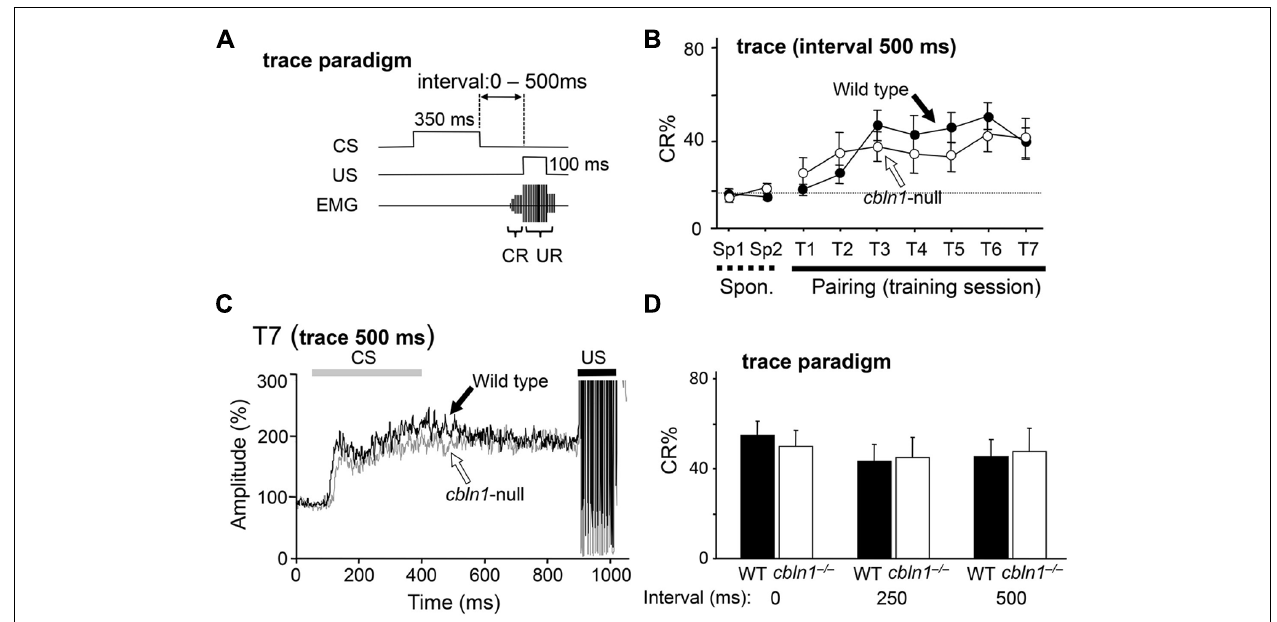
FIGURE 2 |Trace eyeblink conditioning (EBC) is intact in cbln1 − / − mice. (A) Diagram showing trace EBC. An unconditioned stimulus (US, 100 ms) was applied 500 ms after the end of the conditioned stimulus (CS, 350 ms) tone. Mice were trained for 7 days, one session per day. Associative learning was established when conditioned responses (CR), detected by electromyogram (EMG) were observed before unconditioned eyeblink responses (UR). (B) Intact trace EBC in cbln1 − / − mice. No significant difference in CR% was observed between wild-type and cbln1 − / − mice ( p > 0.1, a two-way repeated measures ANOVA, n = 10 mice for each group). T1–T7, training sessions; Sp1 and Sp2, spontaneous eyeblink responses before training. The Y -axis indicates the percentage of trials showing CR. The dotted line corresponds to the